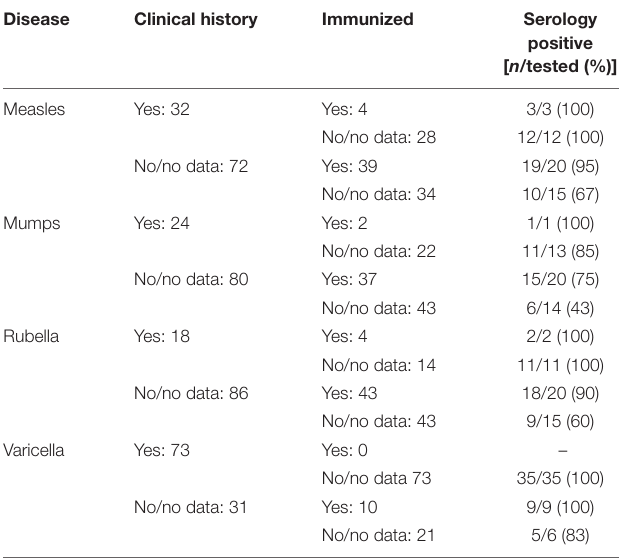
TABLE 2 | Results of antibody measurements for measles, mumps, rubella (MMR) and varicella zoster viruses from serum samples of patients with cartilage-hair hypoplasia.